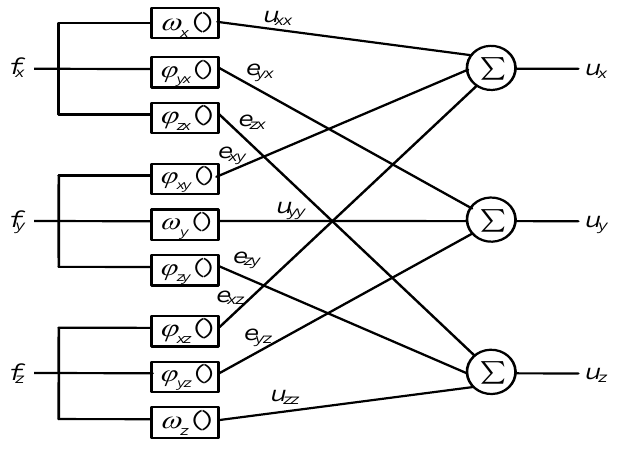
Figure 1. A coupling error model of 3-axis force